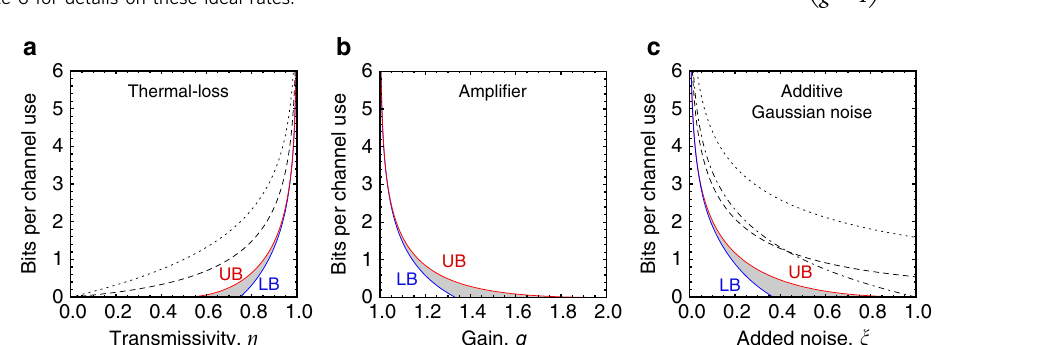
Figure 7 | Two-way capacities for Gaussian channels in terms of the relevant channel parameters. ( a ) Two-way capacity C Z ; (cid:2) n ð Þ of the thermal-loss channel as a function of transmissivity Z for (cid:2) n ¼ 1 thermal photon. It is contained in the shadowed area identified by the lower bound (LB) and upper bound (UB) of equation (25). Our upper bound is clearly tighter than those based on the squashed entanglement, computed in ref. 18 (dotted) and ref. 54 (dashed). Note that C Z ; (cid:2) n ð Þ ’ (cid:2) log 2 1 (cid:2) Z ð Þ(cid:2) h (cid:2) n ð Þ at high transmissivities. For (cid:2) n ¼ 0 (lossy channel) the shadowed region shrinks into a single line. ( b ) Two-way capacity C g ; (cid:2) n ð Þ of the amplifier channel as a function of the gain g for (cid:2) n ¼ 1 thermal photon. It is contained in the shadowed specified by the bounds in equation (27). For small gains, we have C g ; (cid:2) n ð Þ ’ log 2 g = g (cid:2) 1 ð Þ½ (cid:7)(cid:2) h (cid:2) n ð Þ . For (cid:2) n ¼ 0 (quantum-limited amplifier) the shadowed region shrinks into a single line. ( c ) Two-way capacity Cð x Þ of the additive-noise Gaussian channel with added noise x . It is contained in the shadowed region specified by the bounds in equation (30). For small noise, we have Cð x Þ ’ (cid:2) 1 = ln2 (cid:2) log 2 x . Our upper bound is much tighter than those of ref. 18 (dotted), ref. 54 (dashed) and ref. 51